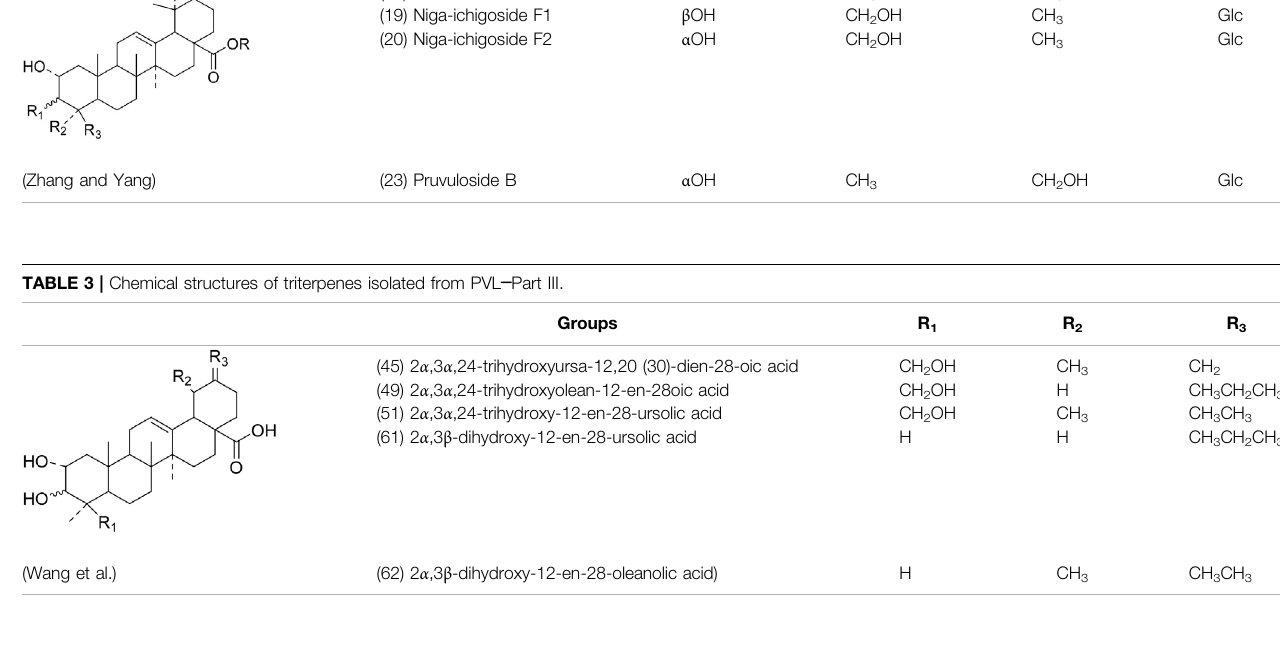
TABLE 4 | Chemical structures of triterpenes isolated from PVL ─ Part IV.